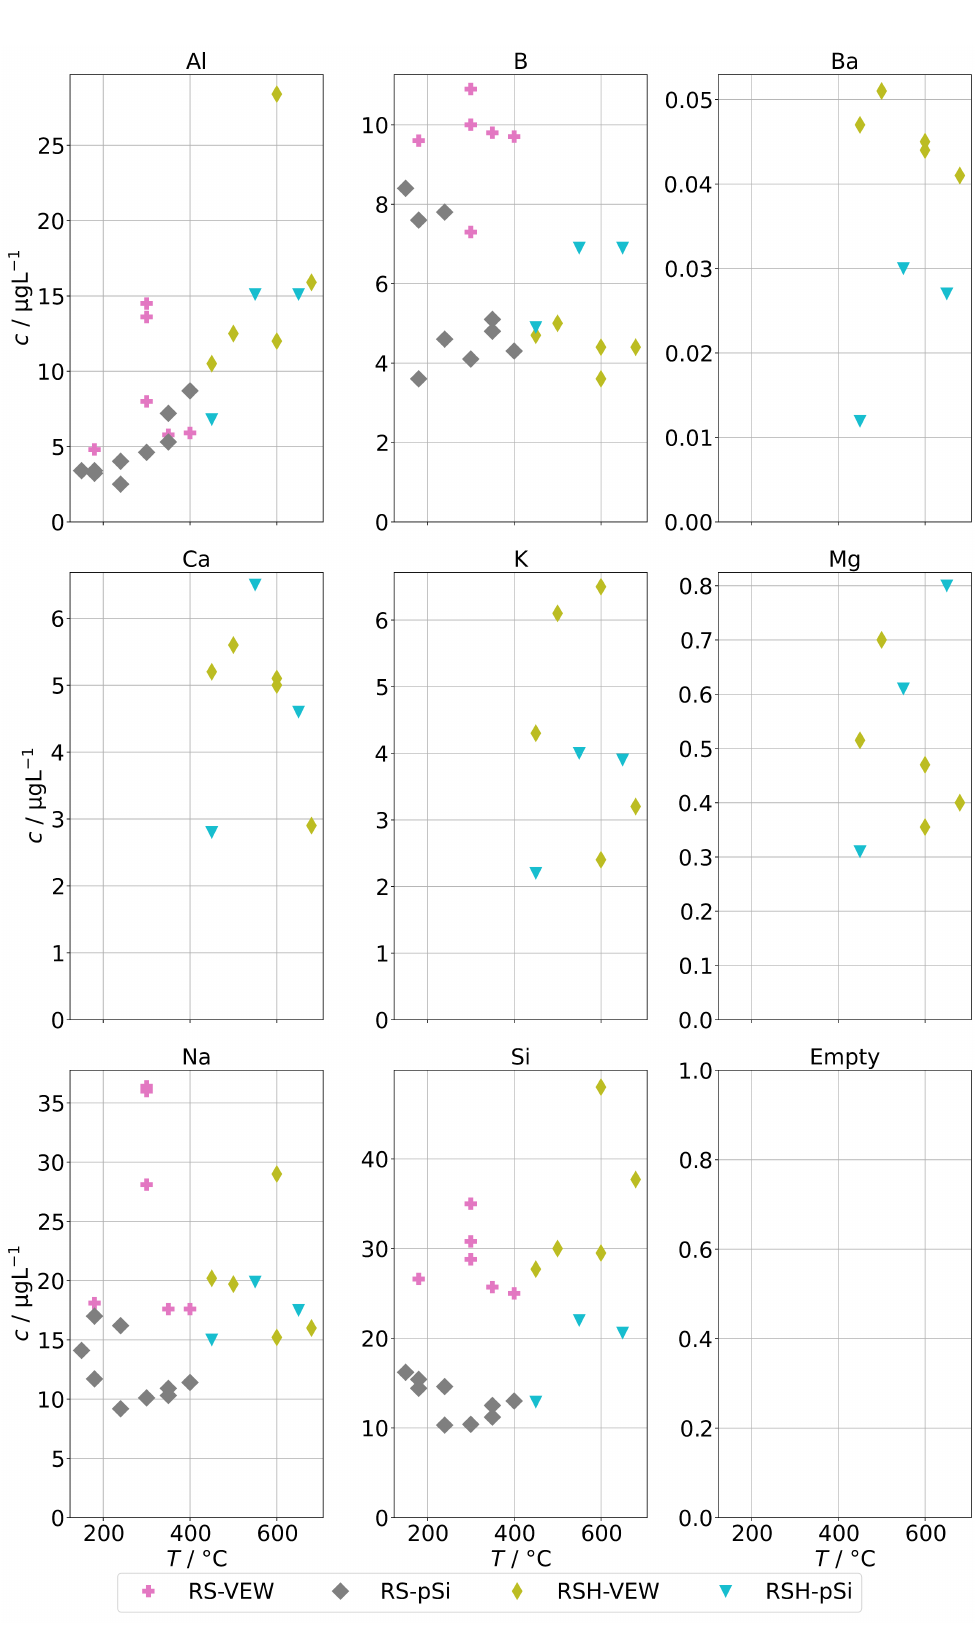
Figure 6. Background concentrations of quantifiable species in condensates of the AG-SG (group B) in dependence of operation